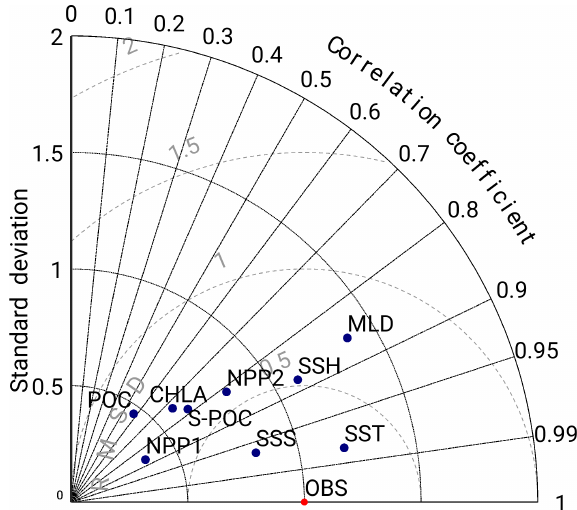
Figure B2. Taylor diagram for the Canary EBUS region of analysis as defined by the budget boxes based on the 24 years climatological annual mean fields used in the present study. Used datasets – sea surface temperature (SST): AVHRR, sea surface salinity (SSS): CARS, sea surface height (SSH): Aviso CMDT Rio05, mixed layer depth (MLD): Argo DT-0.2, chlorophyll (CHLA): SeaWiFS, Net Primary Production dataset 1 (NPP1): SeaWiFS VGPM, Net Primary Production dataset 2 (NPP2): SeaWiFS CbPM, surface particulate organic carbon (S-POC): SeaWiFS POC, particulate organic carbon (POC): cruise POC data (AMT, ANT, Geotraces). A detailed description of the data used for the evaluation is provided in Appendix A: Datasets, Table A1.